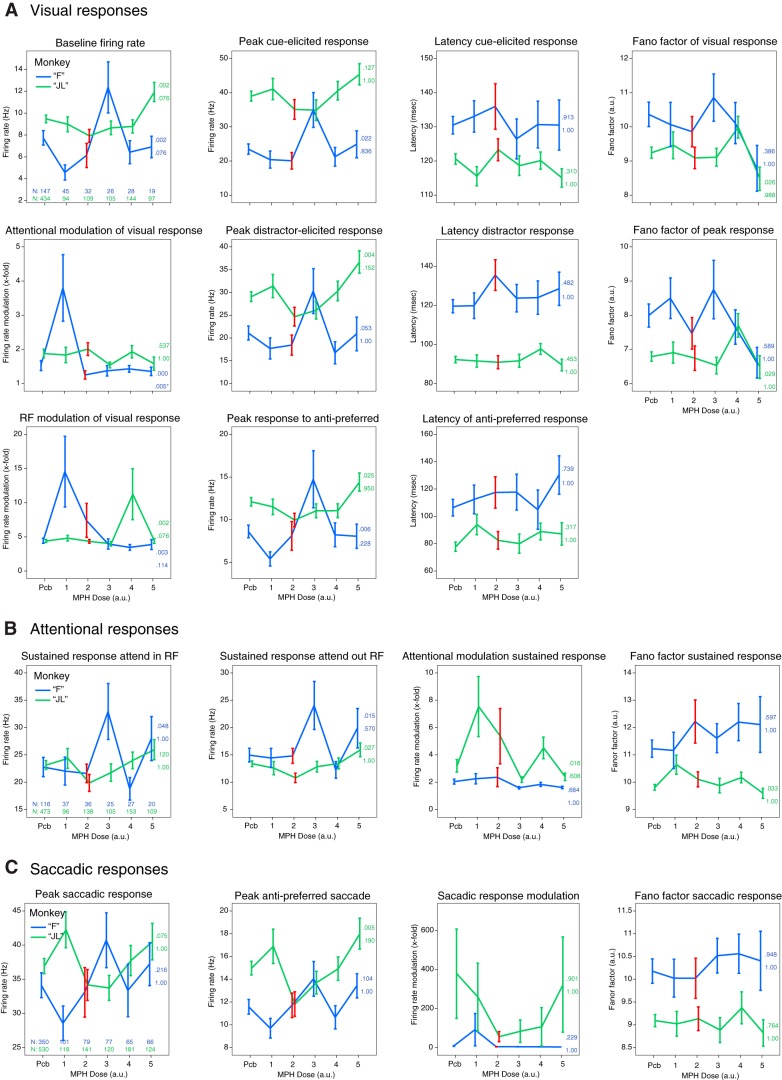
Effects of MPH on 19 single neuron response metrics. A, Visual response metrics for visually-selective neurons as a function of drug dose. Refer to Materials and Methods for the meaning of each metric. The x-axis depicts MPH drug dose using arbitrary units (a.u.), from the smallest dose to the biggest for each monkey. These are 0.43, 0.86, 1.08, 1.29, or 1.72 mg/kg for monkey “F,” and 0.33, 0.67, 0.83, 1.00, or 1.33 mg/kg for monkey “JL.” The y-axis is relative to the particular metric being plotted. Blue and green lines are for monkey “F” and monkey “JL,” respectively. The top-leftmost subplot includes the size of single neurons samples included for the computation of all the visual metrics. The red error bars correspond to the best-dose of MPH according to behavioral performance. The colored numbers to the right of each line represent the p values for the ANOVA test ran for each metric, uncorrected (top), and corrected for multiple comparisons (bottom). B, Same as in A but for the attentional response metrics of attention-selective neurons. C, Same as in A but for the saccadic response metrics of saccade-selective neurons. All error bars represent SEM.